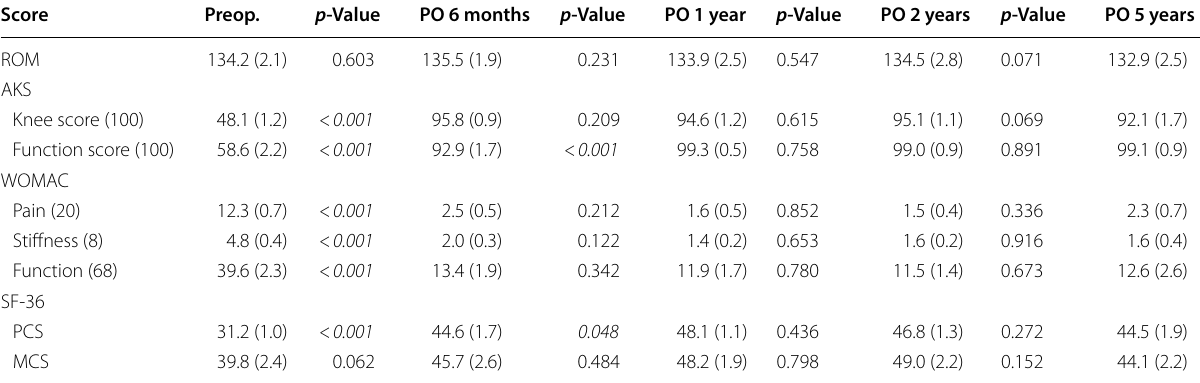
FB fixed bearing, Preop. preoperative, PO postoperative, ROM range of movement, AKS American Knee Society score, WOMAC Western Ontario and McMaster Universities Arthritis Index score, SF-36 36-Item Short Form Health Survey, PCS physical component summary, MCS mental component summary Italics indicates significant p -values